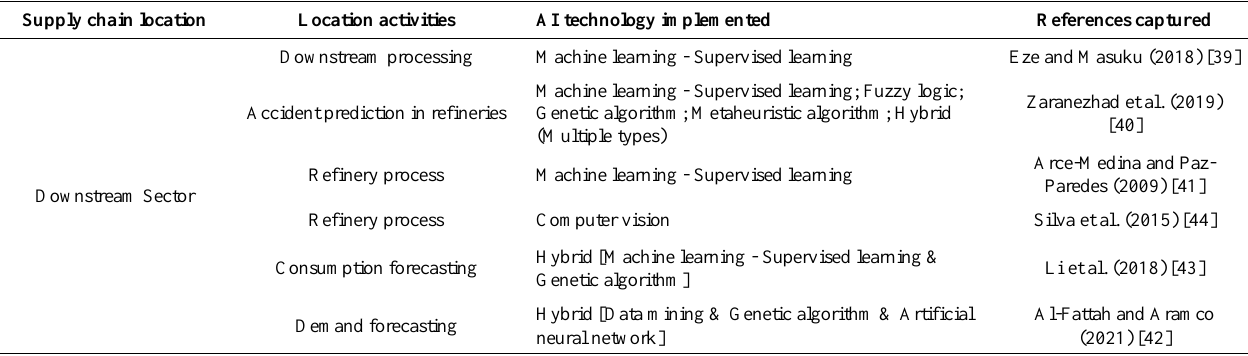
Table 3. Papers focusing on AI technologies applied to downstream